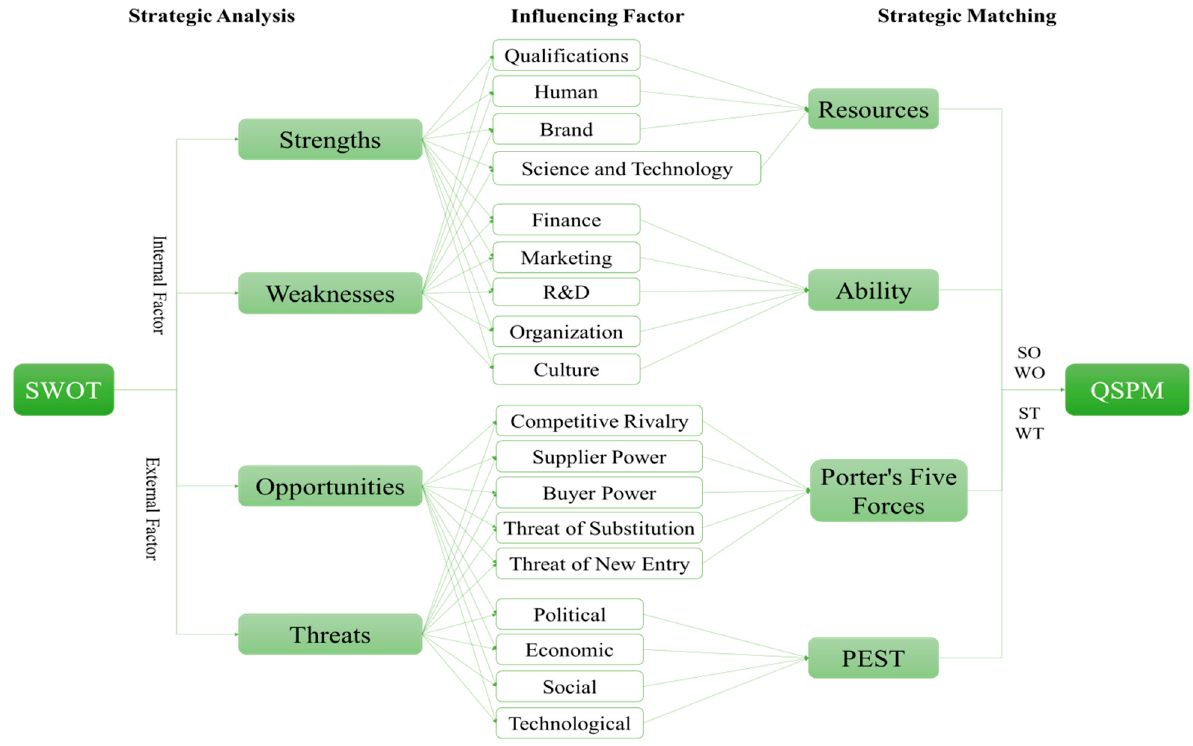
Figure 6. Research framework and methods.